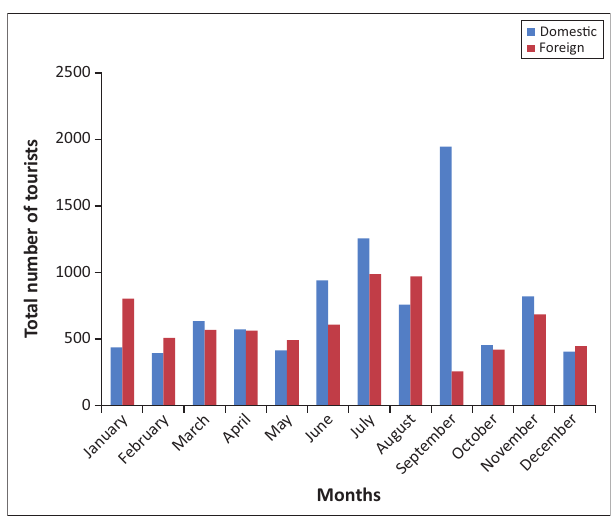
FIGURE 4: Monthly tourist arrivals at Mole National Park in the year 2012.